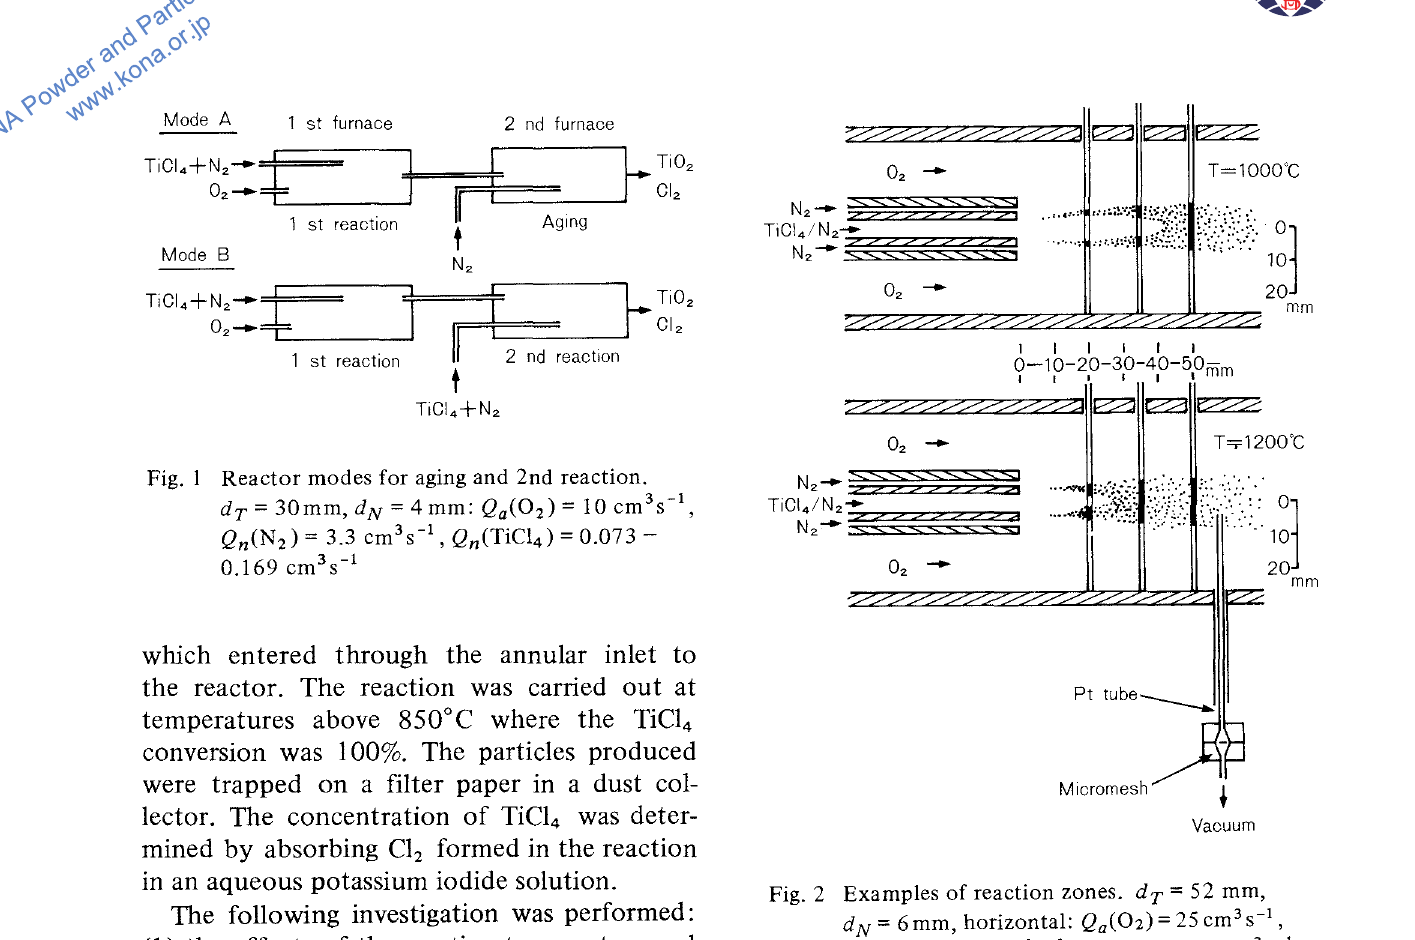
Fig. 2 Examples of reaction zones. dr =52 mm, d N = 6 mm, horizontal: Qa(02) = 25 cm 3 s- 1 , Qs(N2) = 13.4 cm 3 s- 1 , Qn(N2) = 6.7 cm 3 s- 1 , Qn(TiCI = 0.24 cm 3 s- 1 : t = 0.12 4 )